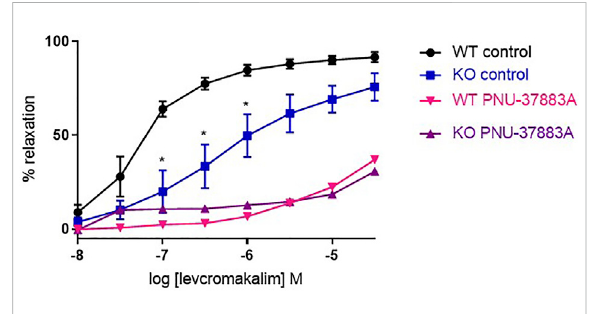
FIGURE 3 The effect of the K ATP -selective channel opener levcromakalim on Kir6.1 KO mouse aortic rings preconstricted with U46619. Levcromakalim-induced relaxation in WT and KO mouse aorta following treatment with the K ATP inhibitor PNU-37883A (3 µm) compared with untreated rings from the same animal. n = 5, data represented as mean ± SEM. * p < 0.05, signi fi cant difference from control curve assessed by 2-way ANOVA followed by Bonferroni multiple comparison